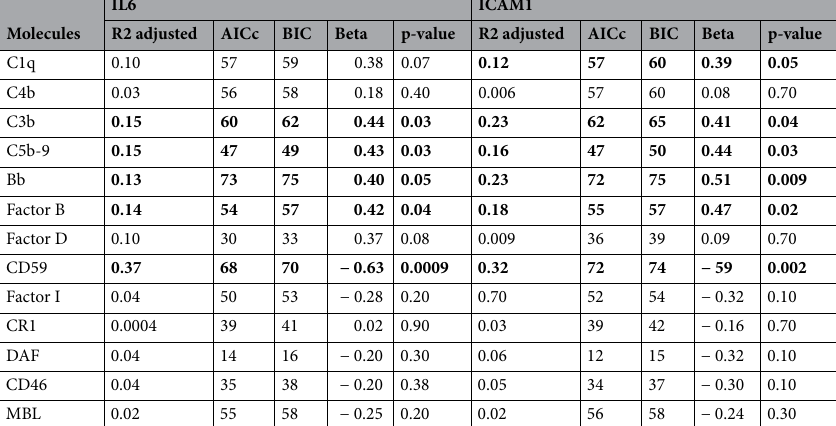
Table 3. Results of Linear Models for IL6 and ICAM1 associations with EDE Complement factors. Illustrated in this table are results of standard least square models with plasma levels of IL6 and ICAM1 as independent variables and EDE cargo as dependent variables.